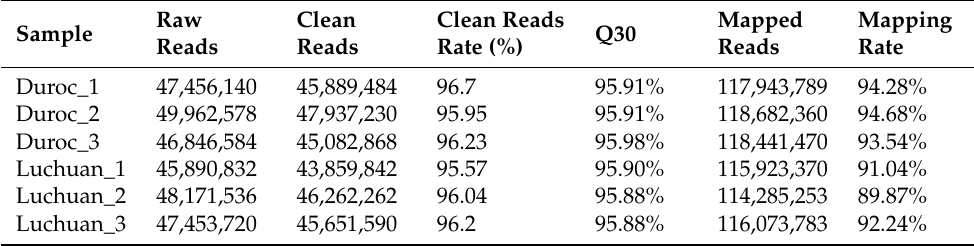
Table 3. Transcriptome data statistics.